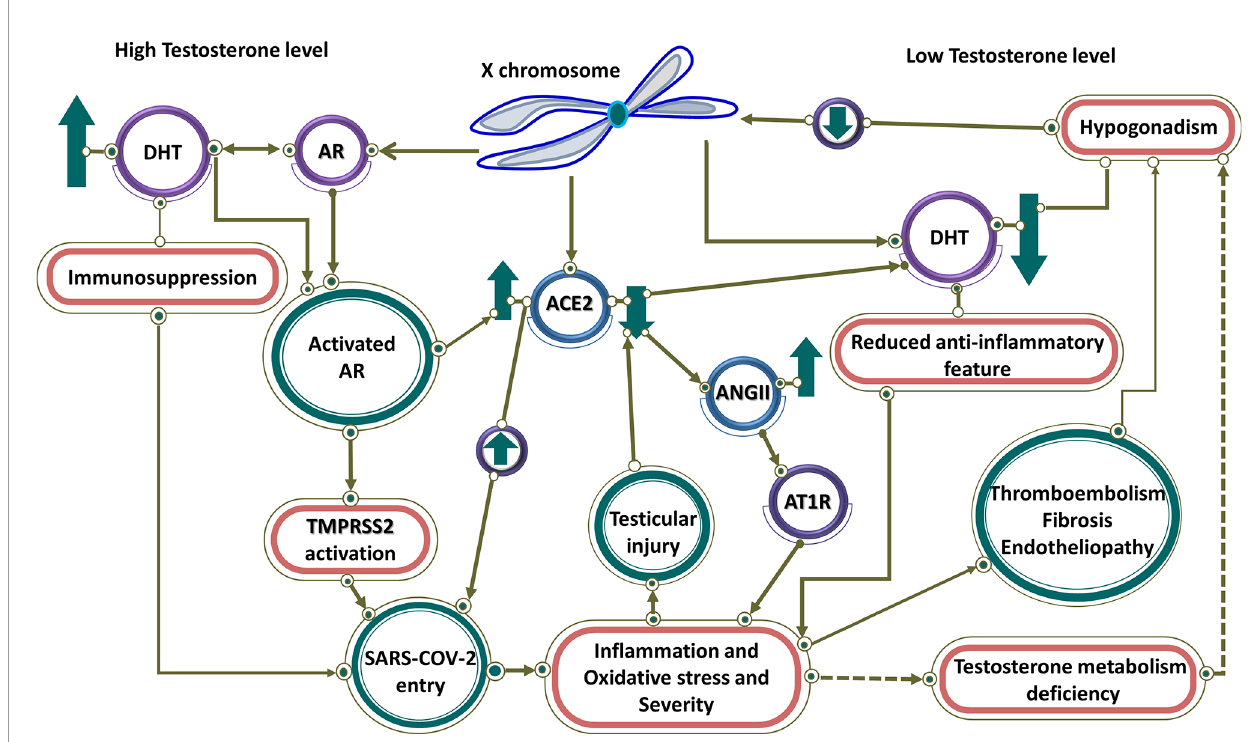
FIGURE 3 | High and low testosterone impact on COVID-19 severity. Controlled by androgen, both TMPRSS2 and ACE2 are regulated by genes on the X chromosome. At high testosterone levels, both receptors are up-regulated, resulting in SARS-CoV-2 entry. Testosterone has an immunosuppressive feature, which leads to more virus entry and disease severity. In contrast, it has linked low testosterone level caused by hypogonadism in men to increased infection of COVID-19. Therefore, in men with hypogonadism, caused by various factors such as reduction of ACE2, testicular damage, and thromboembolism through hyperin fl ammation caused by the viral infection, the level of testosterone is reduced and the anti-in fl ammatory effect of testosterone is blocked, resulting in disease severity. Low testosterone results in downregulation of ACE2 that through activation of AR1T by ANG II leads to in fl ammation and disease